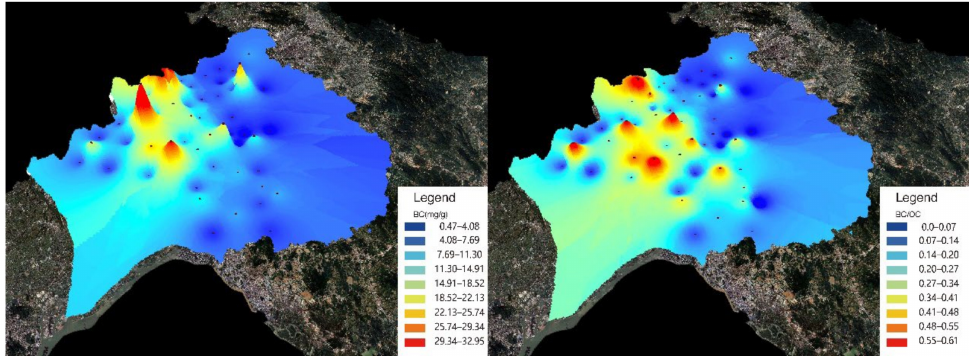
Figure 2. Spatial distribution maps of black carbon (BC) content and black carbon/organic carbon (BC/OC) ratio in soils of Guangzhou, south China.